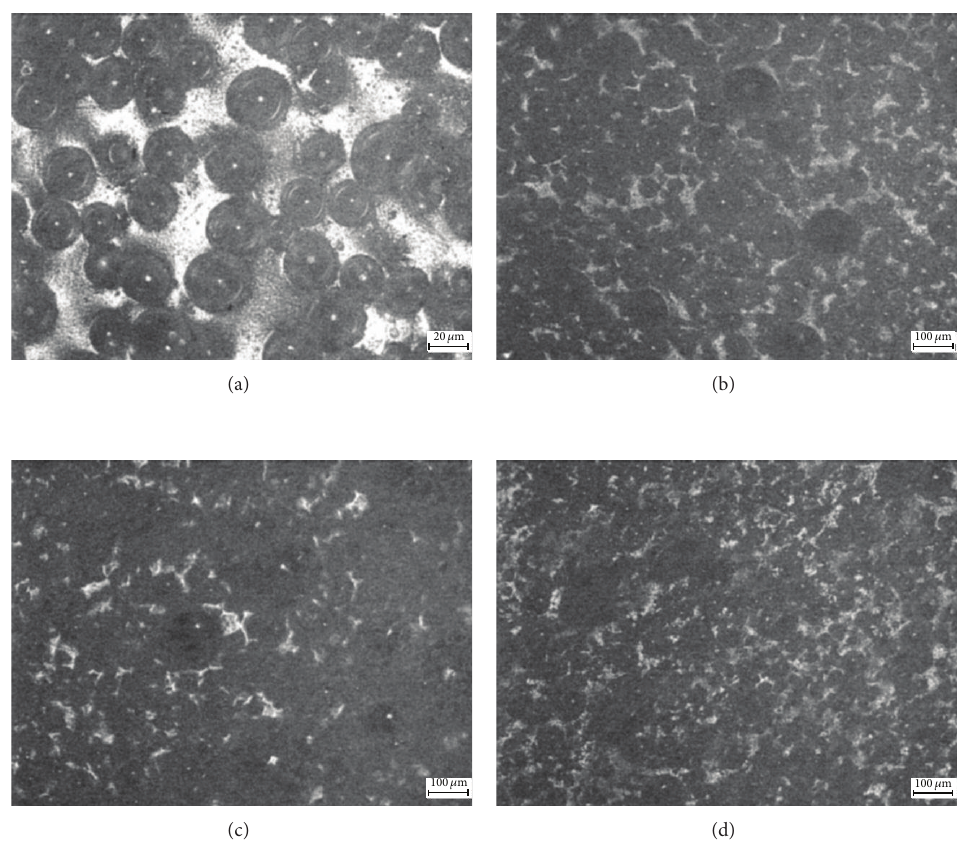
Figure 1: (a) Plain PUR (b) PUR + 1Wt.% NC (c) PUR + 2Wt.% NC (d) PUR + 3Wt.% NC.